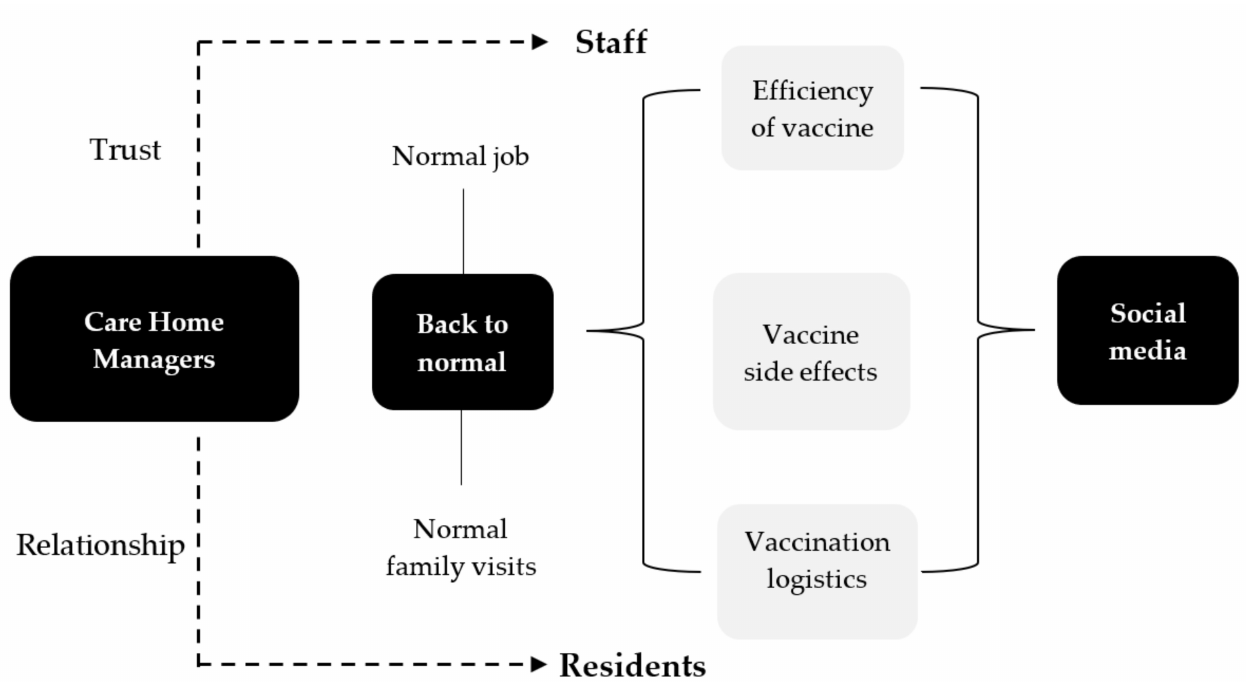
Figure 4. Care Home manager challenges in improving COVID-19 vaccine